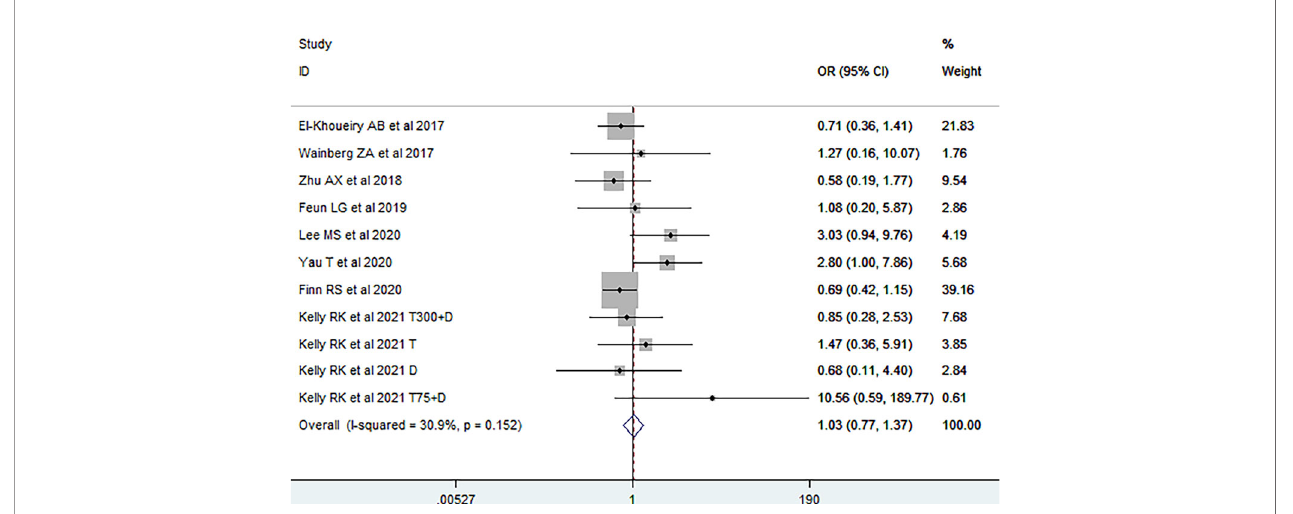
FIGURE 2 | Pooled odds ratio of response rate between virally infected and uninfected